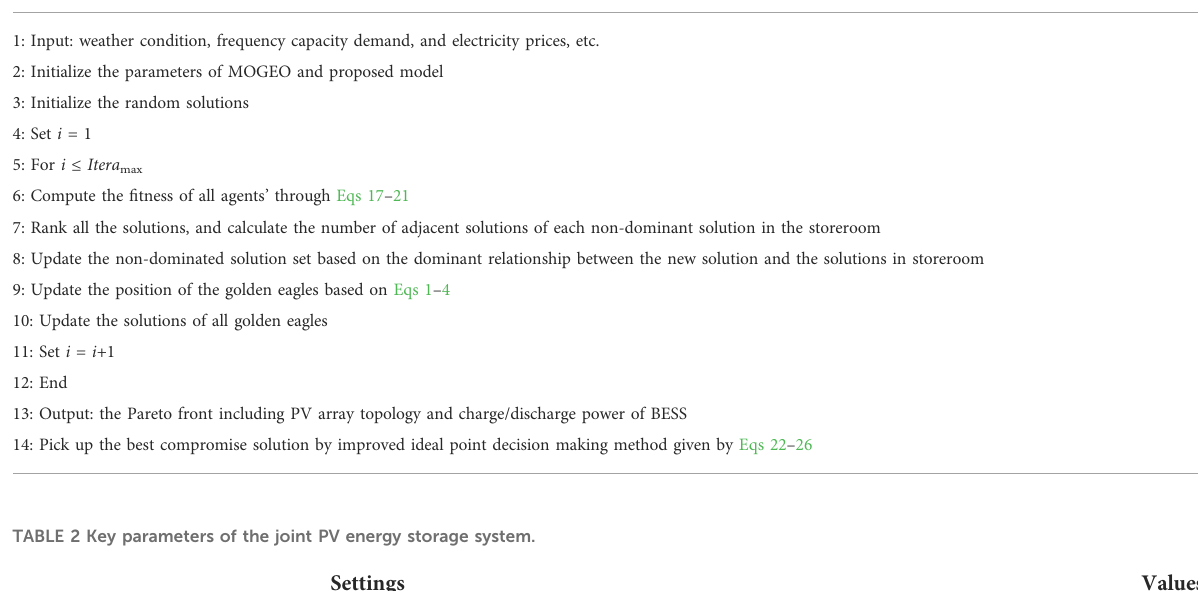
TABLE 1 The procedure pseudocode of joint PV energy storage system recon fi guration.